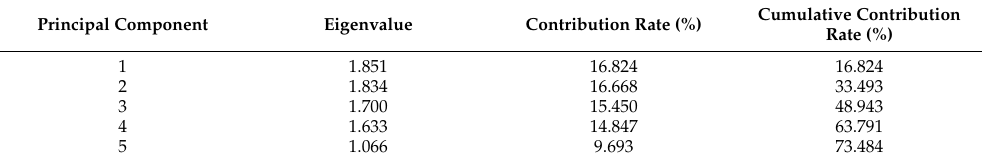
Table 6. Total variance explained.